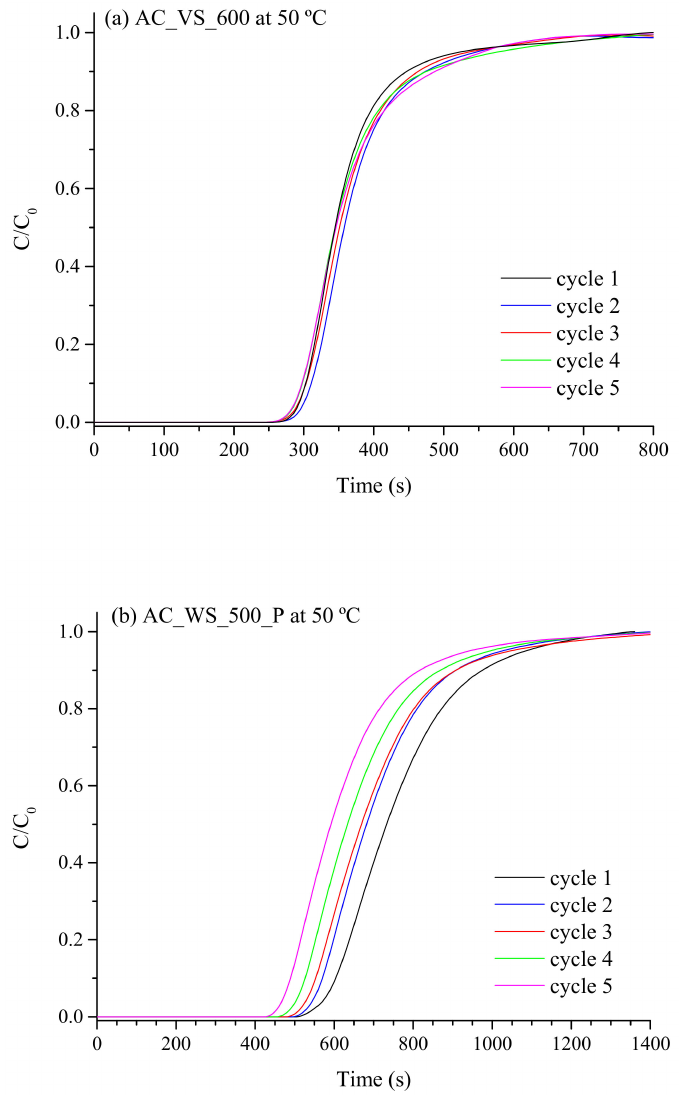
Figure 5. CO 2 breakthrough curves for five consecutive cycles (adsorption temperature = 50 ◦ C) from a dry binary mixture of N 2 and CO 2 (with a CO 2 composition of 13.75–14.25 vol. %) using the AC_VS_600 ( a ) and AC_WS_500_P ( b )